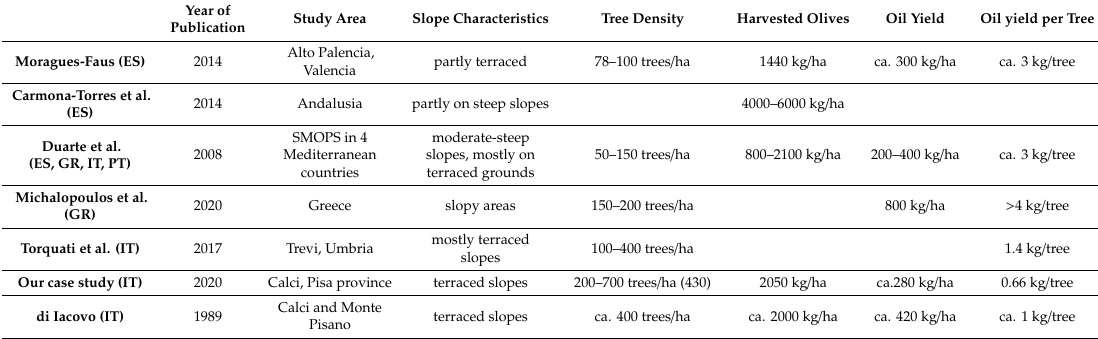
Table 10. Comparison of several production performances in Mediterranean traditional olive